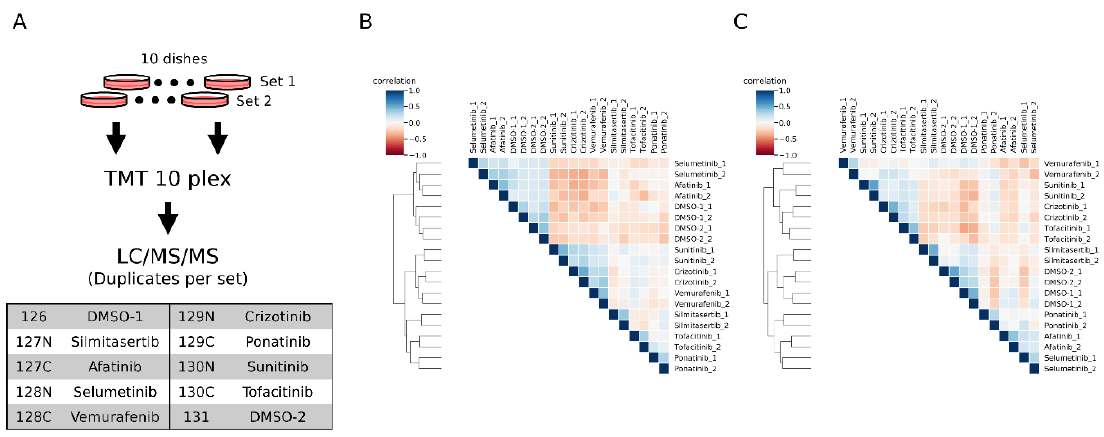
Figure 4. Phosphoproteomic profiling of inhibitor-treated HeLa cells. ( A ) Schematic representation of the workflow. 10 cell dishes were prepared for each set of experiments, and treated with different inhibitors or vehicle DMSO. The peptides extracted from each cell dish were labeled with each channel of TMT 10 plex labeling reagents shown in the table. ( B , C ) Heatmaps show the unsupervised clustering results of Kendall correlations calculated with the normalized intensities. The results from conventional ( B ) and motif-targeting ( C ) workflows are shown.